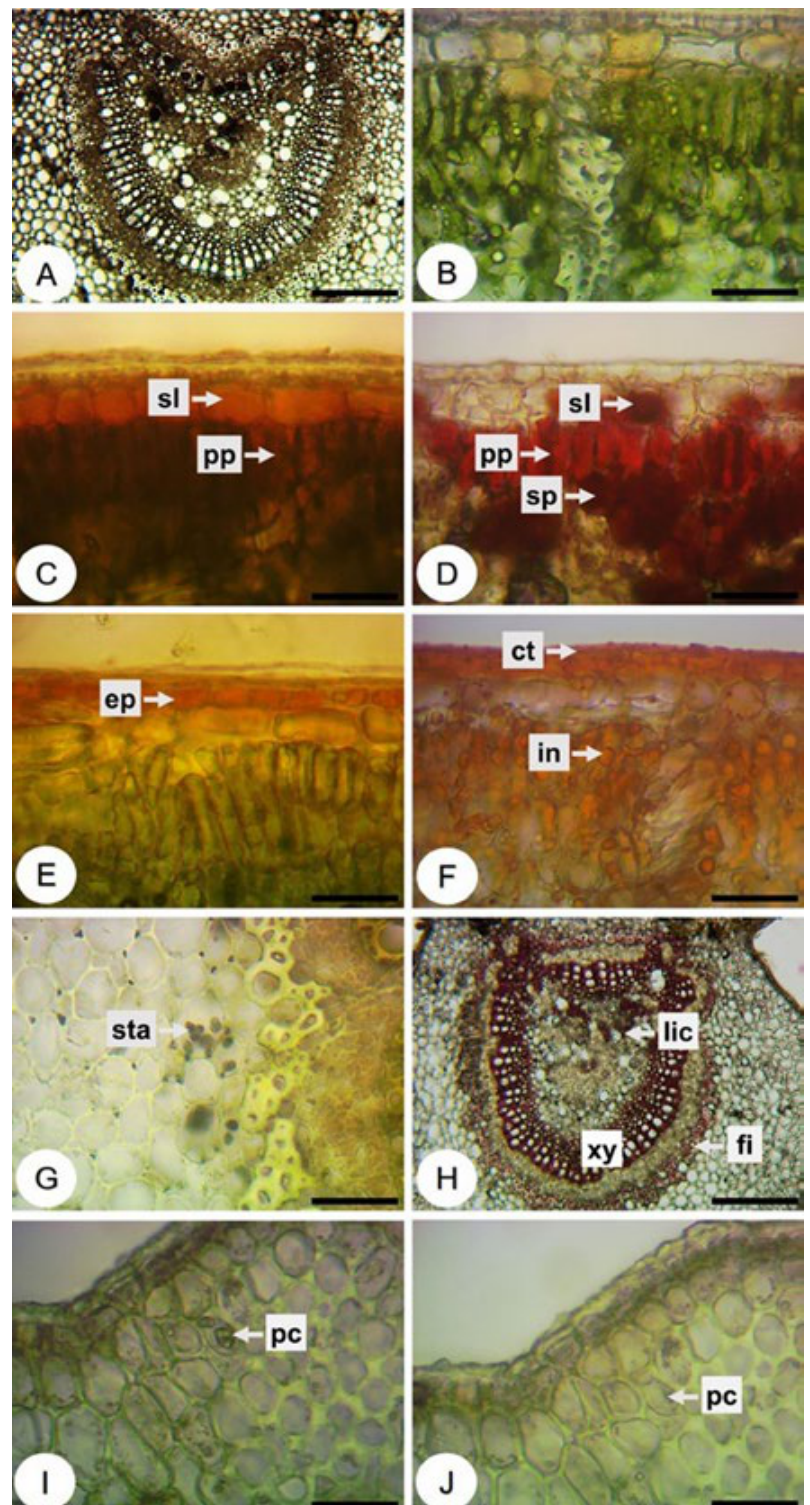
FIGURE 6 - Cross-sections of the leaf blade of Manilkara zapota (L.) P.Royen (Sapotaceae) – histochemistry. A: midrib. B: mesophyll. C: potassium dichromate (10%). D: vanillin hydrochloric acid. E: antimony trichloride. F: Sudan III. G: Lugol’s iodine reagent. H: phloroglucinol. I, J: hydrochloric acid (10%). Abbreviations: ct = cuticle; ep = epidermis; fi = fiber; in = inclusion; lic = lignified cell; pc = prismatic crystal; pp = palisade parenchyma; sl = subepidermal layer; sp = spongy parenchyma; sta =